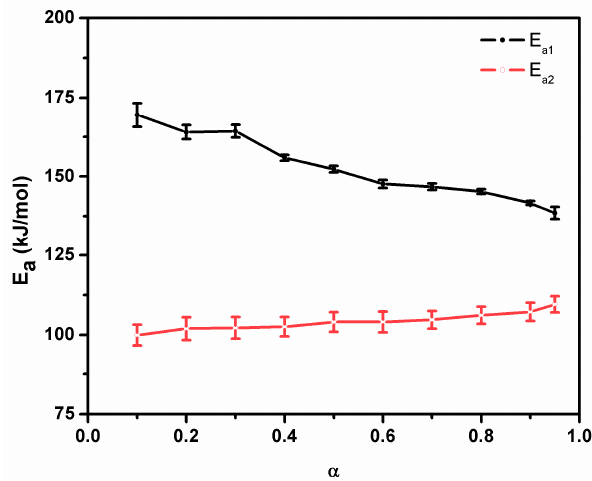
Figure 5. Variation in activation energy values according to the Flynn–Wall–Ozawa (FWO) method for P-ddm/APbPc blends.